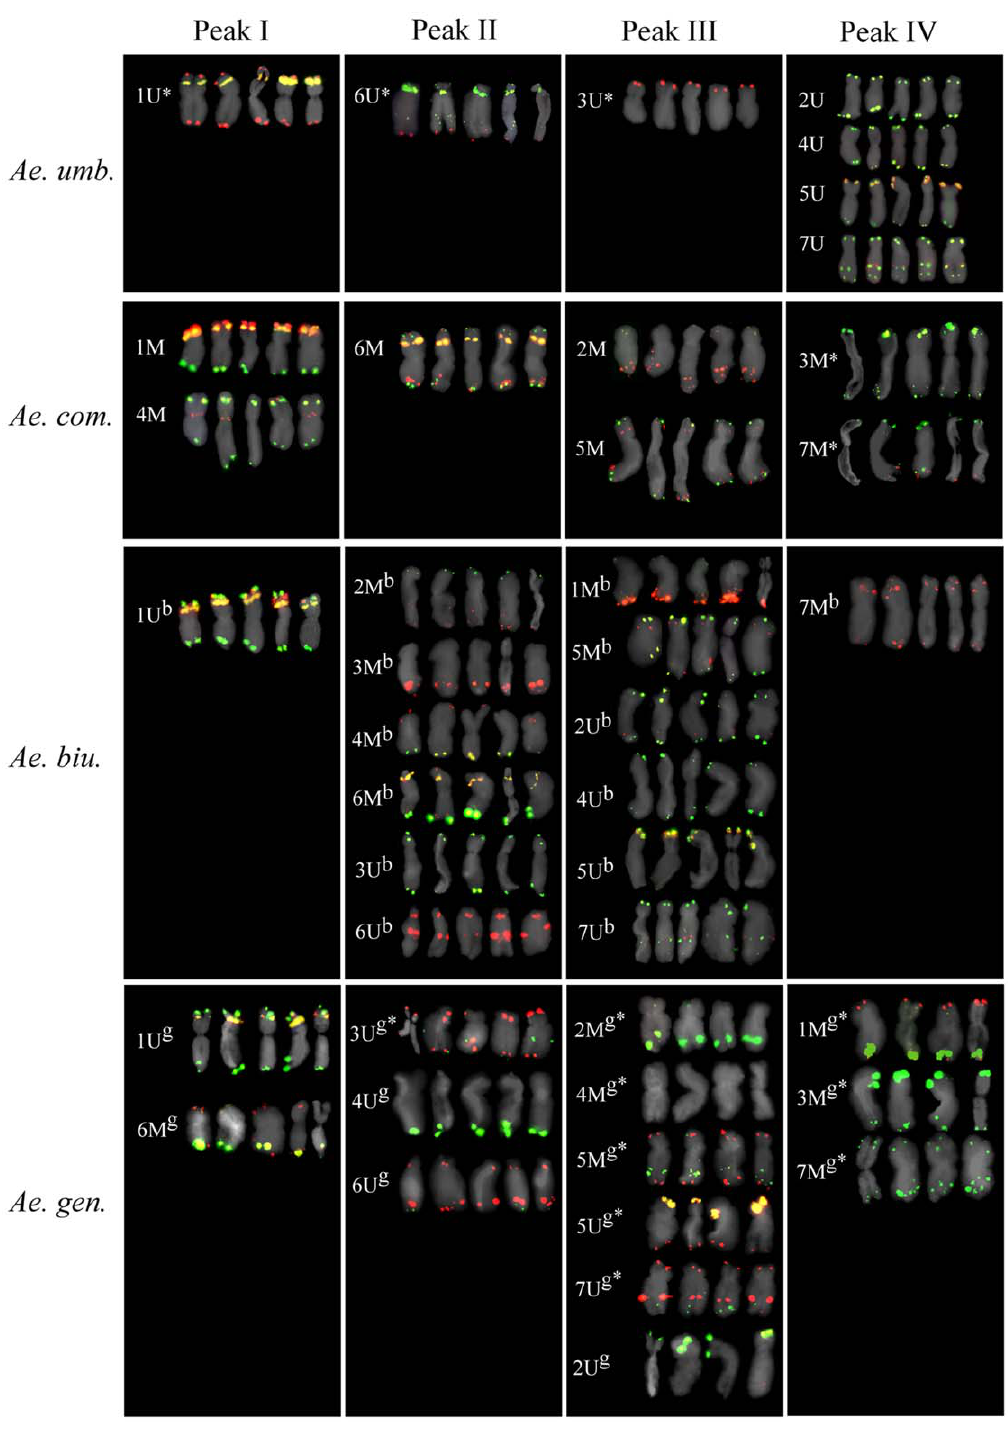
Figure 3. Flow-sorted chromosomes. Mitotic metaphase chromosomes were sorted from individual peaks of flow karyotypes of Ae. umbellulata , Ae. comosa , Ae. biuncialis and Ae. geniculata . Sorted chromosomes were identified after FISH with probes for repetitive DNA: pSc119.2 (green), Afa family (red) and pTa71 (yellow) (Inverse labelling of probes is marked by asterisk). The chromosomes are shown in peaks where their frequencies were the highest. For each chromosome, four to five representative examples are given.